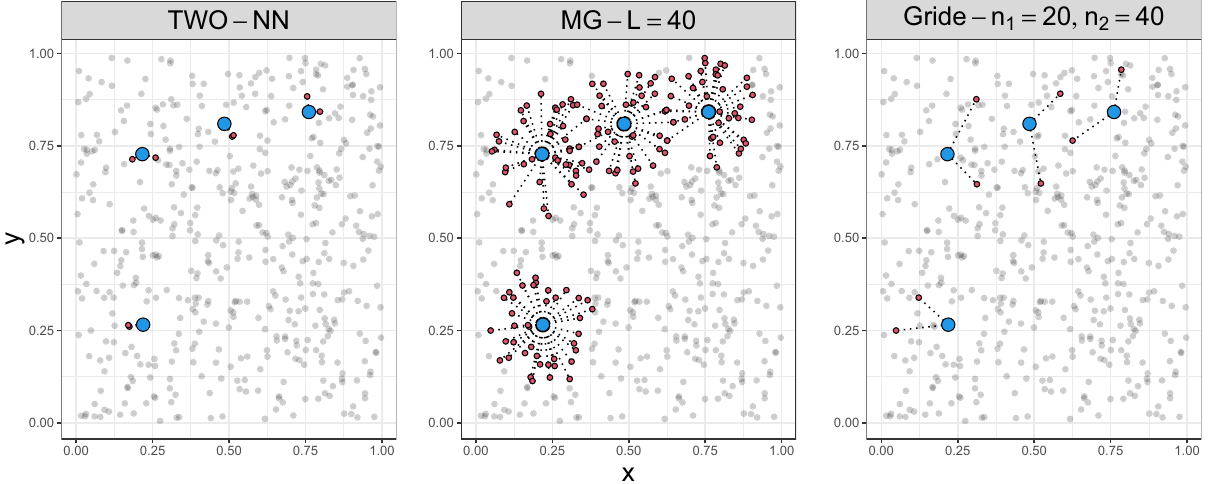
Figure 2. Neighboring points (in red) and distances (dotted lines) involved in the id estimation centered in four data points (in blue). Each panel corresponds to one model: TWO-NN , MG ( L 20, n 2 40 ) , ( n 1 Gride = =